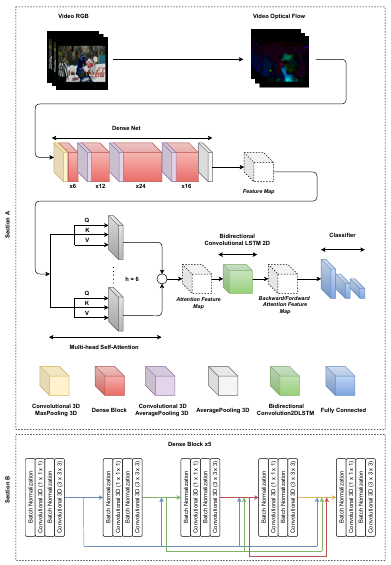
Figure 1. In Section A the architecture of the ViolenceNet model, that takes the optical flow as input, is shown. It is composed of four parts: a DenseNet-121 network spatio-temporal encoder, a multi-head self-attention layer [39], a bidirectional convolution 2D LSTM (BiConvLSTM2D) layer and a classifier. Below each Dense Block its number of components is indicated. The variable h corresponds to the number of heads used in parallel by the multi-head self-attention layer and the variables Q , K , V their inputs. Section B shows the internal architecture of a five-component Dense Block